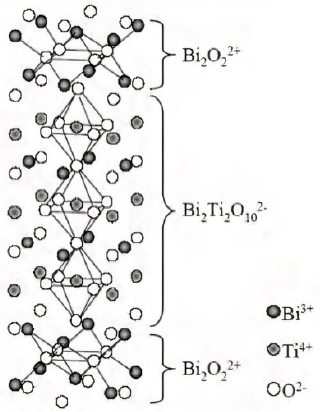
Figure 1. Crystal Structure of bismuth titanate (BiTi) [3].